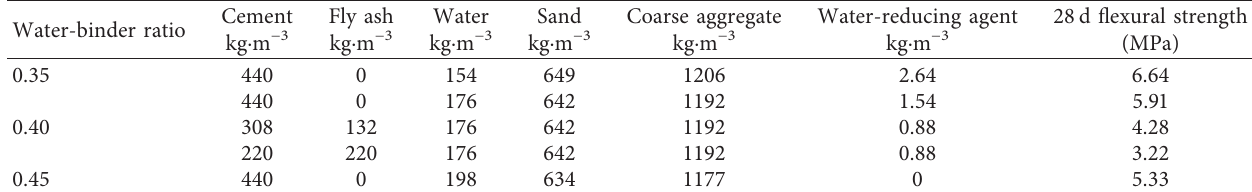
Table 2: Mix proportion of concrete.